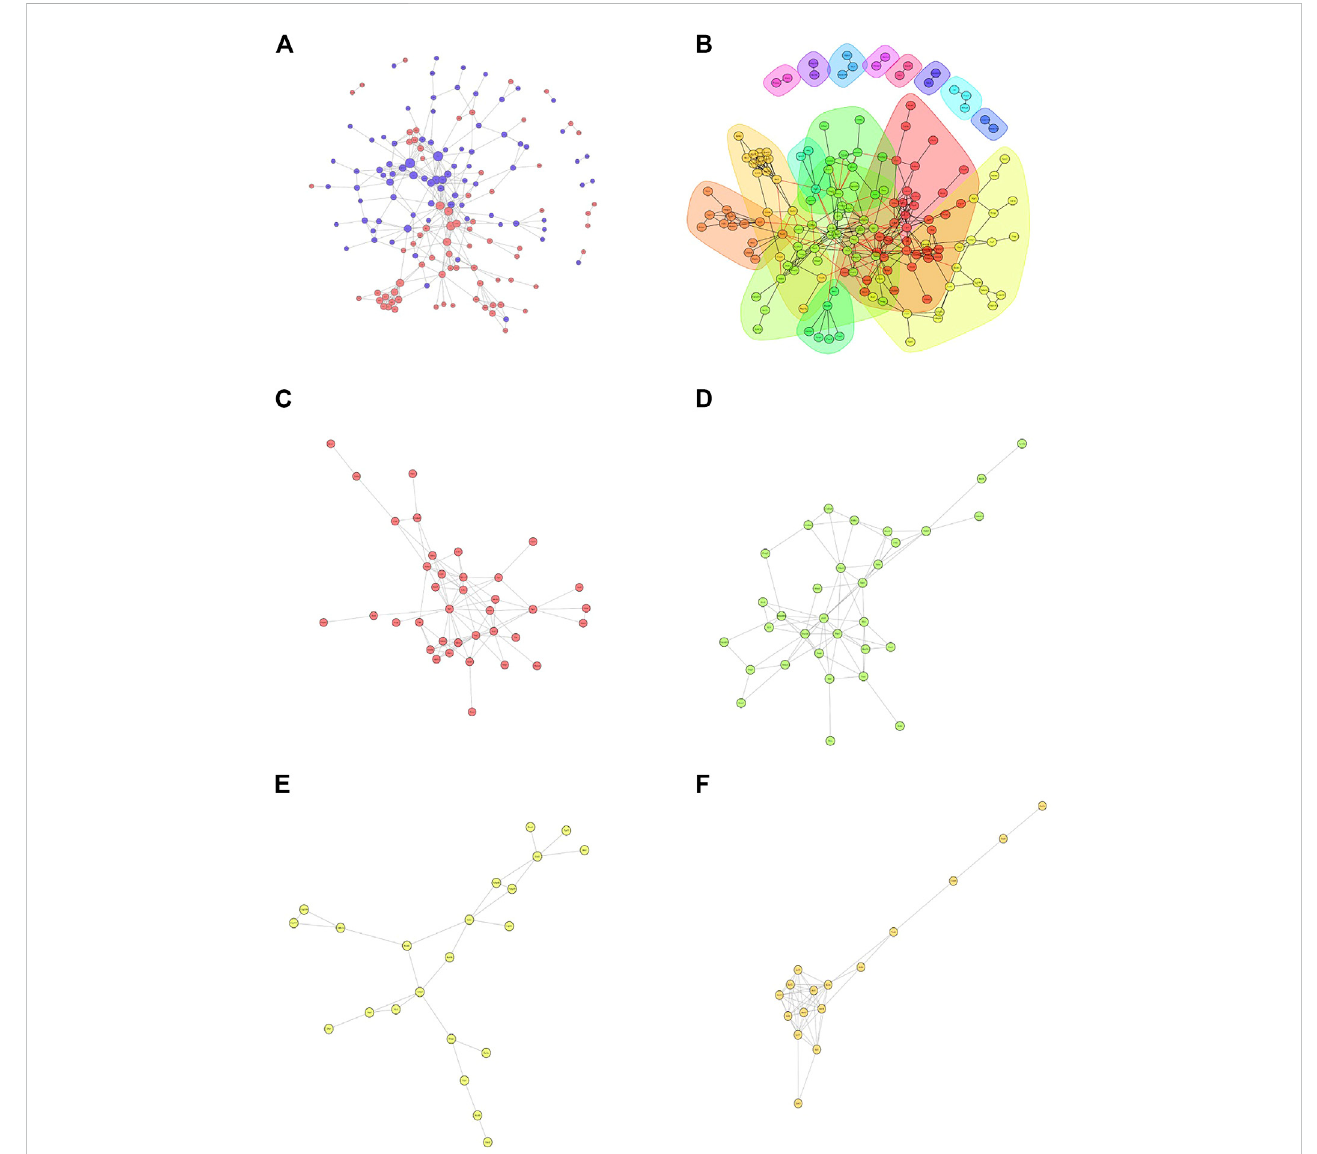
FIGURE 4 Analyses of the protein-protein interaction networks for the differentially expressed proteins in loperamide-treated. (A) Group differentially expressed protein interaction network diagram. (B) Interaction network diagram for functional classi fi cation diagram (C – F) interaction network of key genes diagram.